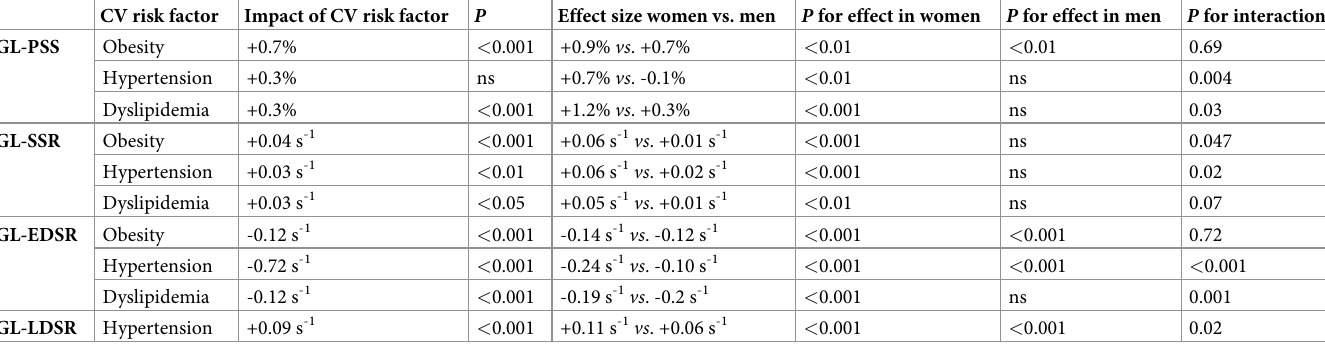
Table 4. Impact of cardiovascular risk factors on myocardial deformation in the total cohort and according to